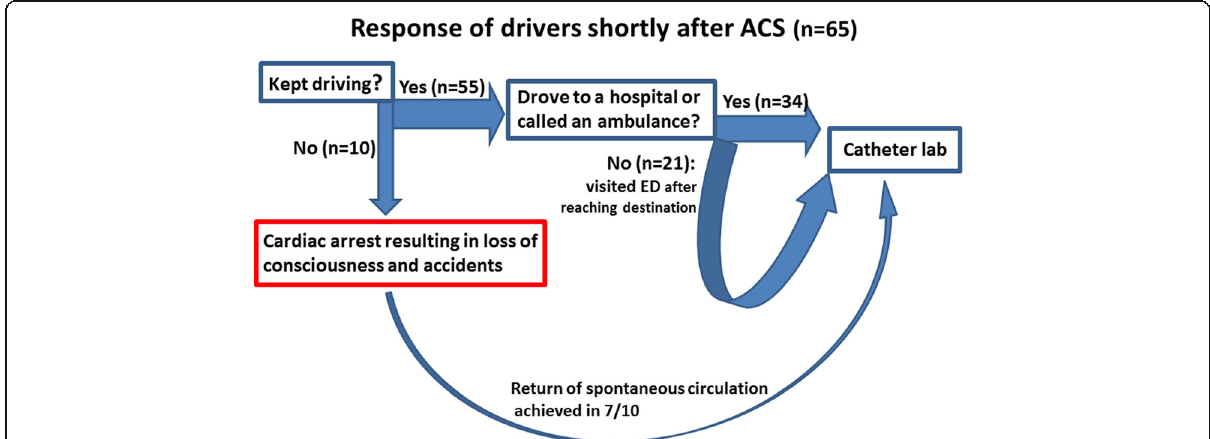
Fig. 1 The response of 65 drivers to ACS is illustrated. Fifty-five (85%) kept driving. Among them, 34 either drove directly to a local hospital or called an ambulance for help. The other 21 drivers visited the emergency room (ER) after reaching their destinations. The remaining 10 drivers (15%) sustained cardiac arrest with subsequent loss of consciousness and automobile accidents. Seven of 10 drivers with cardiac arrest achieved return of spontaneous circulation after resuscitation and were taken to the catheter